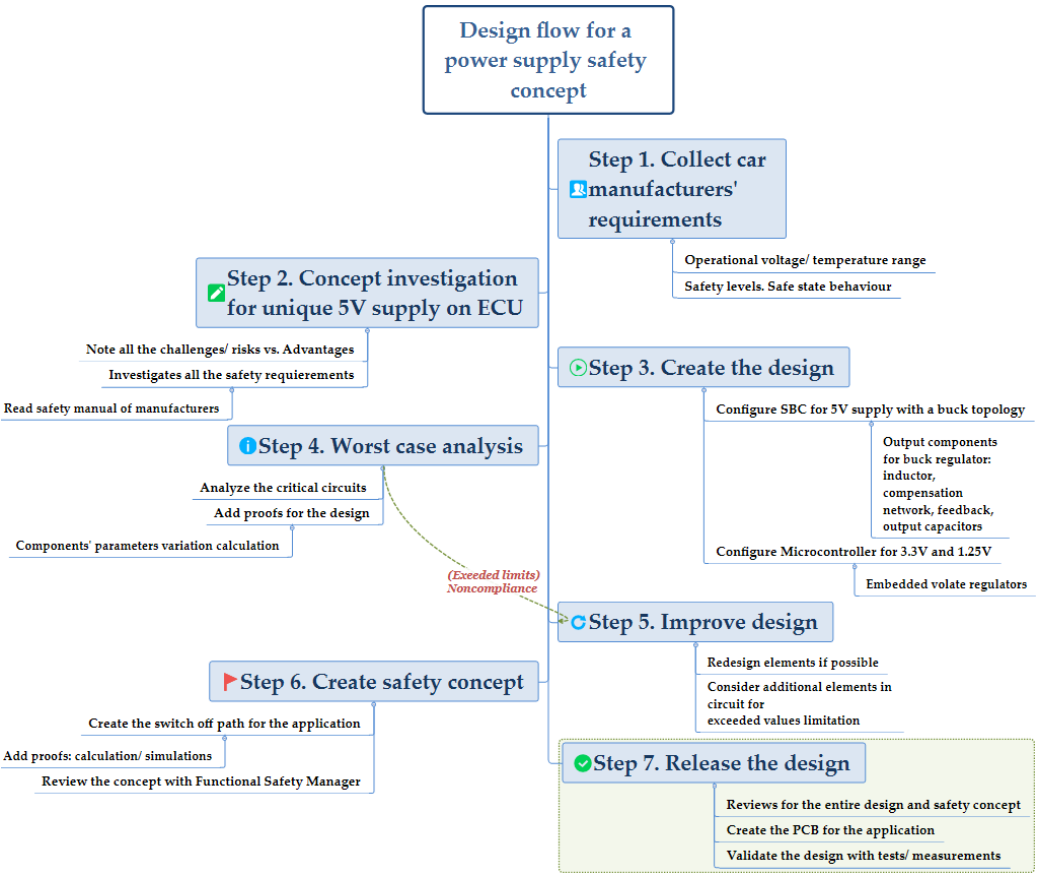
Figure 4. Proposed power supply design steps for safety-relevant applications.